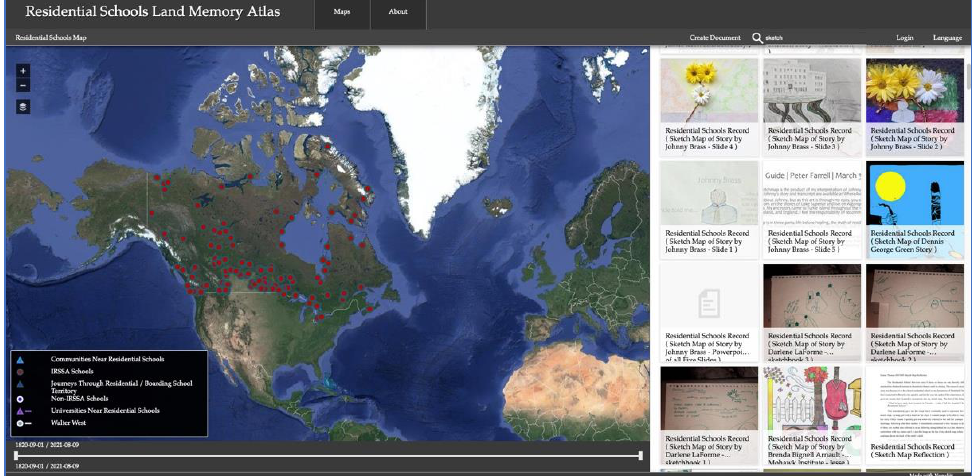
Figure 4. Screenshot of Residential Schools Map of the Residential Schools Land Memory Atlas, showing thumbnail views of the student sketch mapping output in the side panel and the locations for the schools identified in the Indian Residential Schools Settlement Agreement (IRSSA; see https://www.rcaanc-cirnac.gc.ca/eng/1100100015576/1571581687074, (accessed on 27 April 2022)) in the center map panel.